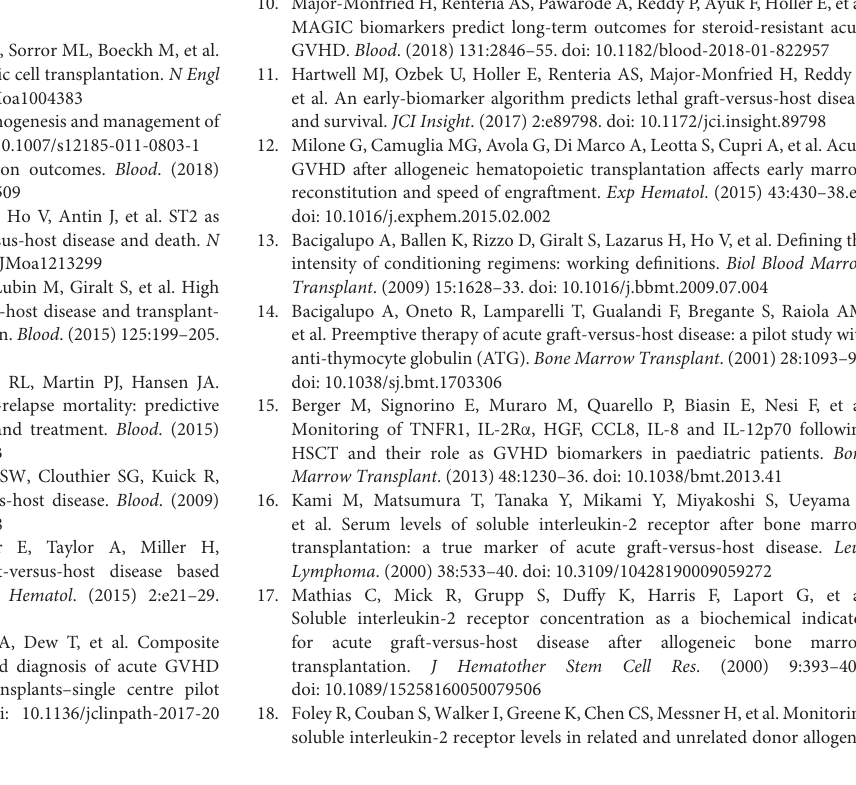
Supplementary Table 1 | AUC of ROC curves of each cytokine in regard of OS and of TRM. Supplementary Table 2 | Clinical and hematological features in patients grouped according to composite